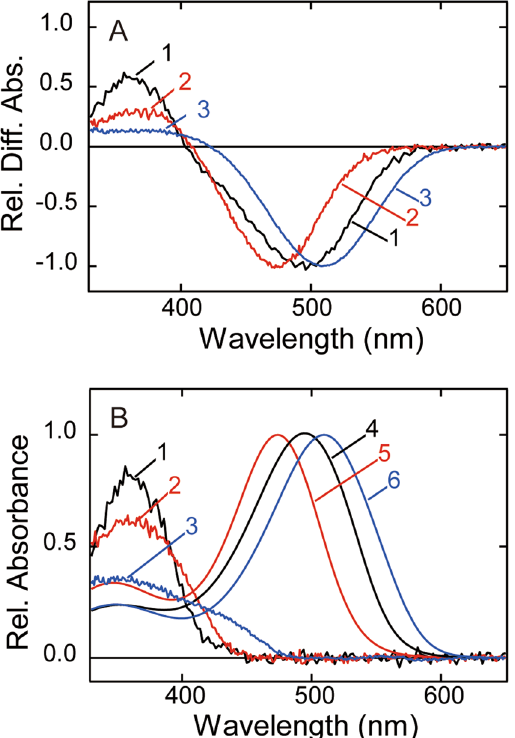
Figure 4. Spectral comparison of Rh7, parapinopsin, and Opn5m. ( A ) Spectral changes from all- trans - to 11- cis -retinal bound forms of lamprey parapinopsin (curve 1), chicken Opn5m (curve 2) and Drosophila Rh7- Cap (curve 3). Spectra were normalized to be ~1.0 at the negative maximum. ( B ) The calculated absorption spectra of three UV light-sensitive opsins (11- cis -retinal bound forms, curves 1–3) and their active states (all- trans -retinal bound forms, curves 4–6). Difference spectra of parapinopsin and Opn5m (curves 1 and 2 of ( A )) were fitted with a template spectrum of bovine rhodopsin meta-I modeled by the Lamb and Govardovskii method 22, 23 to calculate absorption spectra of all- trans -retinal bound forms (curves 4 and 5, respectively). Difference spectrum of Rh7 (curve 3 of ( A )) was fitted with a template spectrum of squid retinochrome modeled by the Lamb and Govardovskii method to calculate the absorption spectrum of the all- trans -retinal bound form (curve 6). It should be noted that we calculated absorption spectra of three pigments by using the spectrum of squid retinochrome as a template; however, the base lines of spectra were not steady except for that of Rh7 (Fig. S3). Spectra of 11- cis -retinal bound forms of parapinopsin, Opn5m and Rh7 were determined by subtracting the difference spectra in ( A ) from the calculated spectra of all- trans -retinal bound forms (curves 1, 2 and 3,